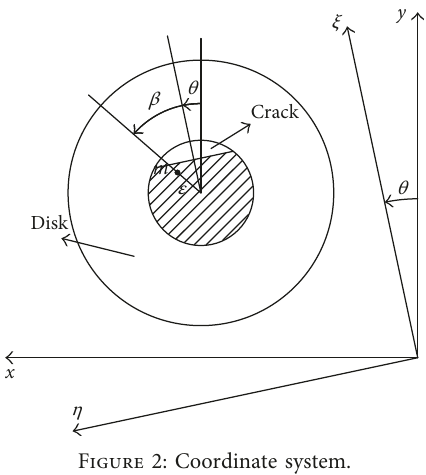
Figure 2: Coordinate